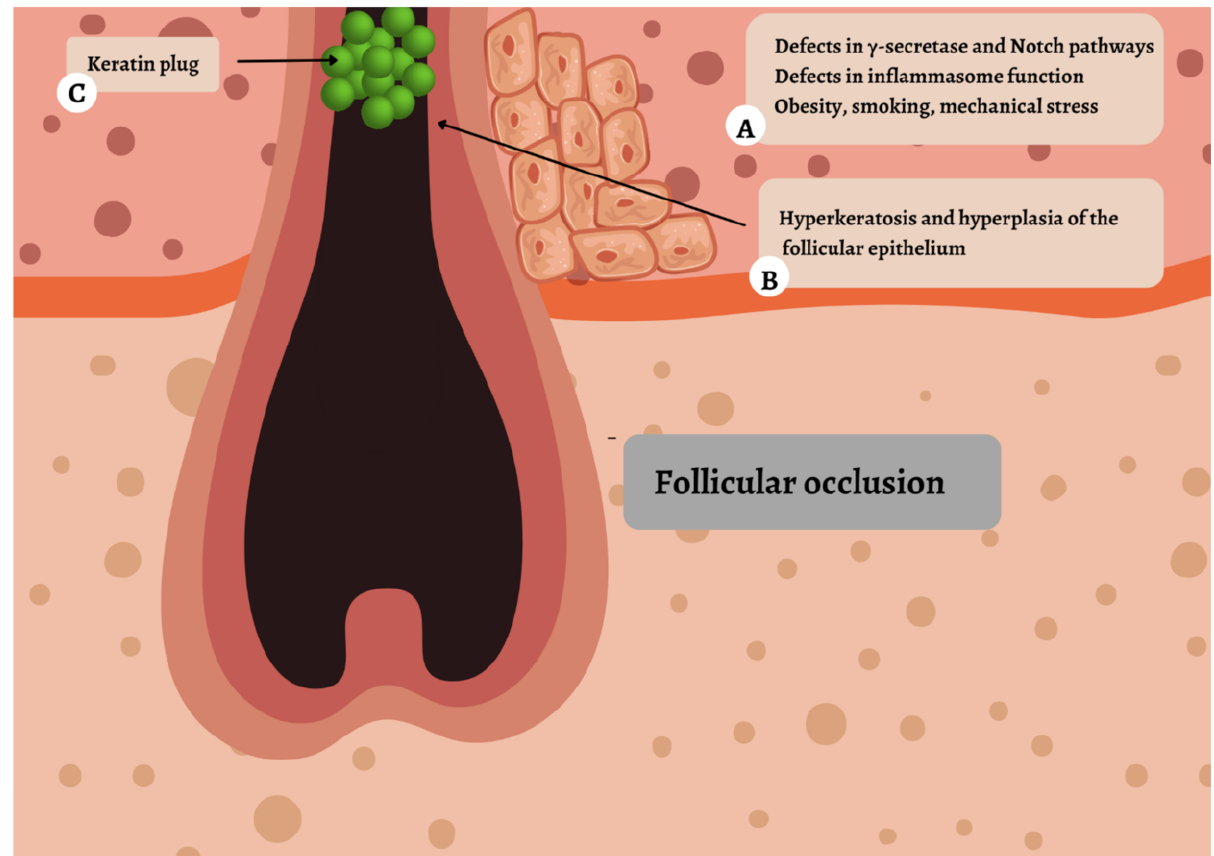
Figure 1. The first event in HS development is follicular occlusion. Genetic predisposition, mechan- ical stress, and environmental factors (A) induce hyperkeratosis and hyperplasia of the follicular epithelium (B). This results in the accumulation of cellular debris and the formation of a keratin plug